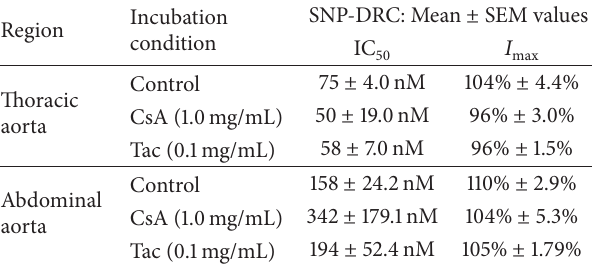
Table 2: The comparative effects of in vitro incubation with either CsA (1mg/mL) or Tac (0.1mg/mL) for 30min. Duration on sodium nitroprusside (SNP-) evoked vasodilator responses in phenylephrine (PE-1 𝜇 M)-constricted rat aortic rings with intact